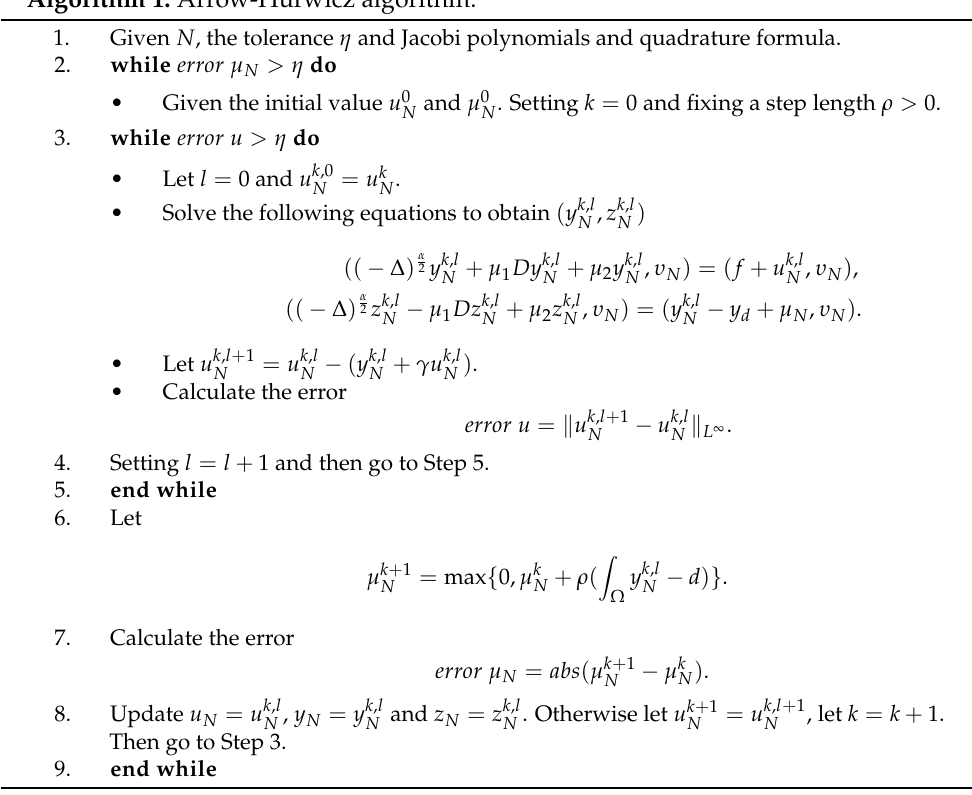
Algorithm 1: Arrow-Hurwicz